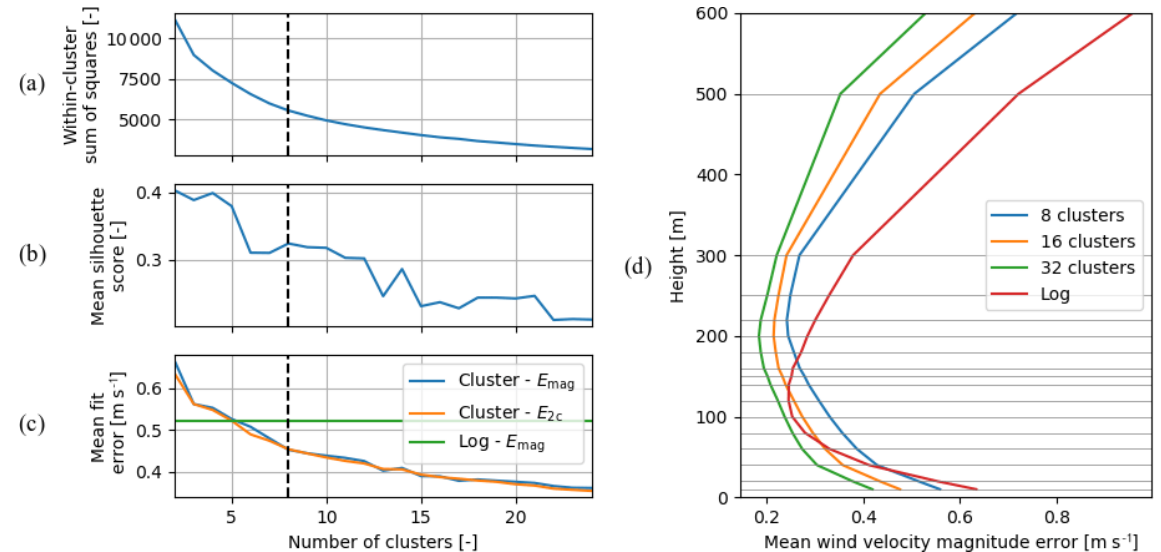
Figure 5. Sensitivity of the k -means clustering performance to the number of clusters over the full vertical grid (a–c) and for each height (d) for the filtered offshore dataset. Cost function of the clustering algorithm (a) , cluster cohesiveness metric (b) , and the mean wind speed fit error (c) against the number of clusters. The dashed vertical lines depict the final choice for eight clusters.